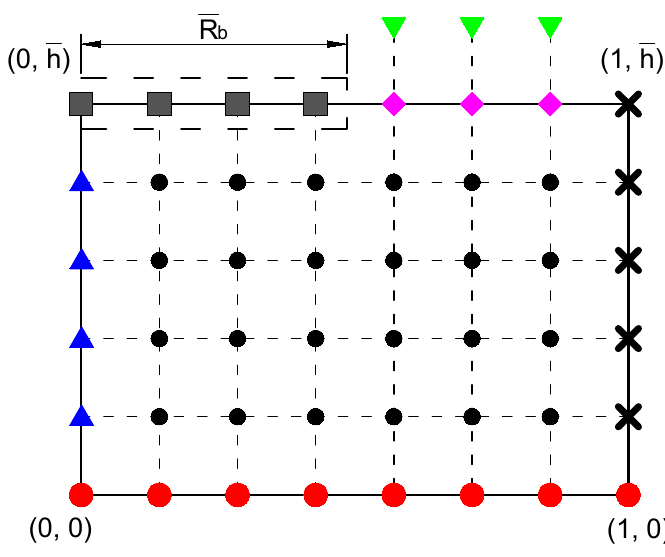
Figure 1. Sketch of the new mesh. Blue up triangles: nodes at the cylindrical symmetry axis inside the subphase. Red dots: nodes at the bottom wall of the cup. Grey squares: nodes at the bicone surface. Black dots: nodes inside the fluid subphase. Black crosses: nodes at the outer cup wall. Magenta diamonds: nodes at the interface. Green down triangles: phantom nodes above the